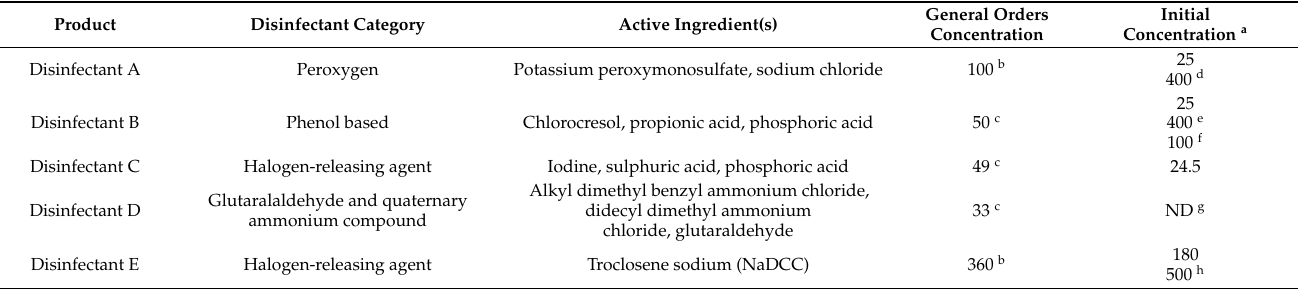
Table 2. Characteristics of the disinfectants used and their recommended concentrations (as of March